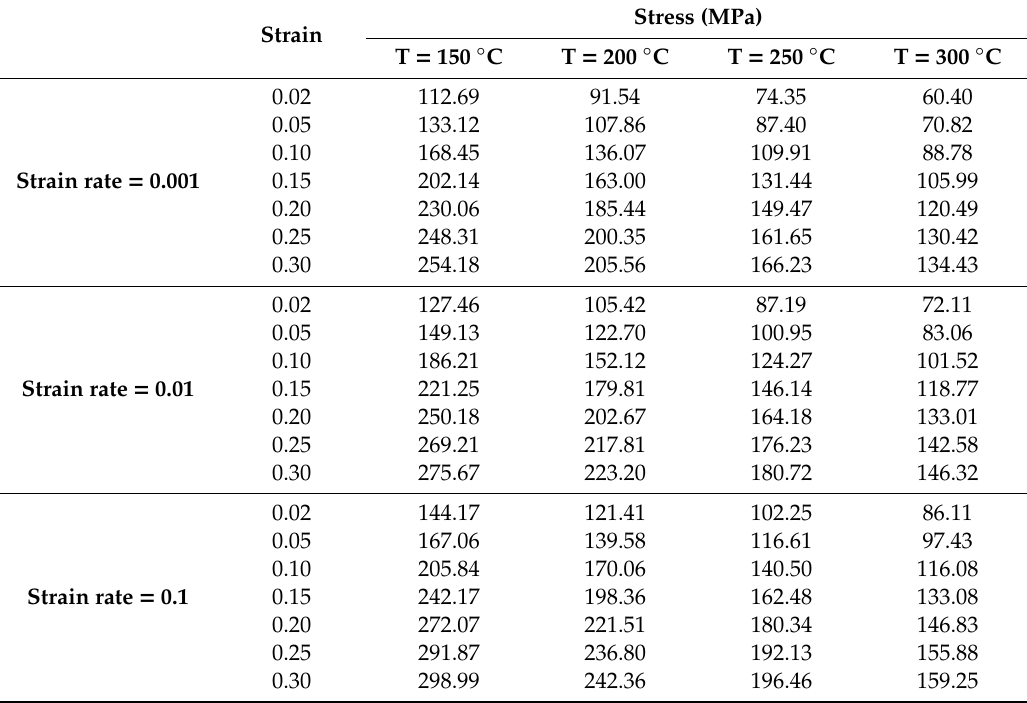
Table 4. AZ31B flow curves values based on Wen-Juan exponential model. Strain